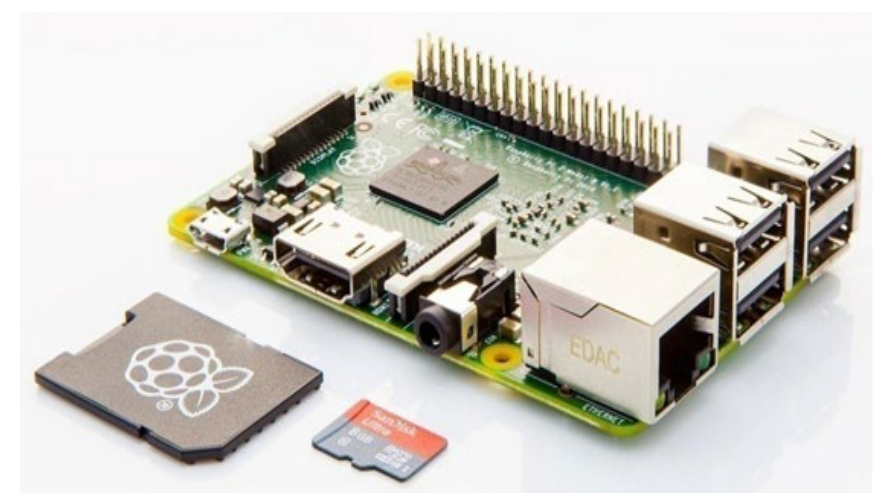
Figure 8. IoT Security